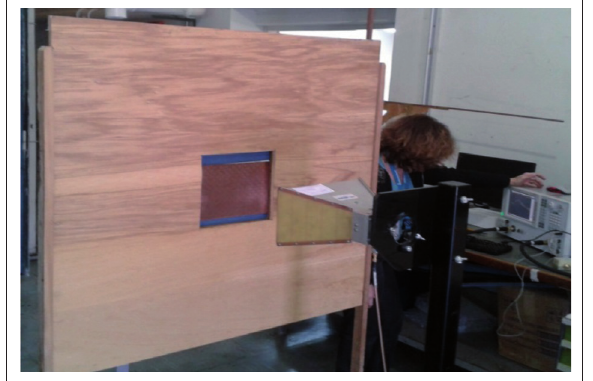
Figure 6. CST simulation setup of the FSS in a channel with two broadband horn antennas (the blown up is shown in detail, up right).